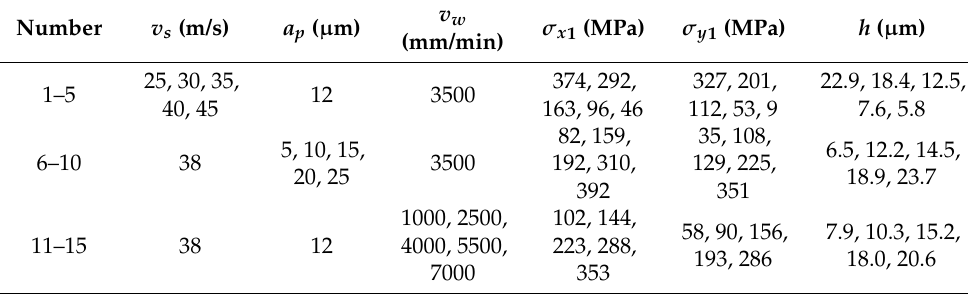
Figure 12. Relationship between residual stress at the location of crack propagation and crack propagation depth. Table 2. Grinding experimental